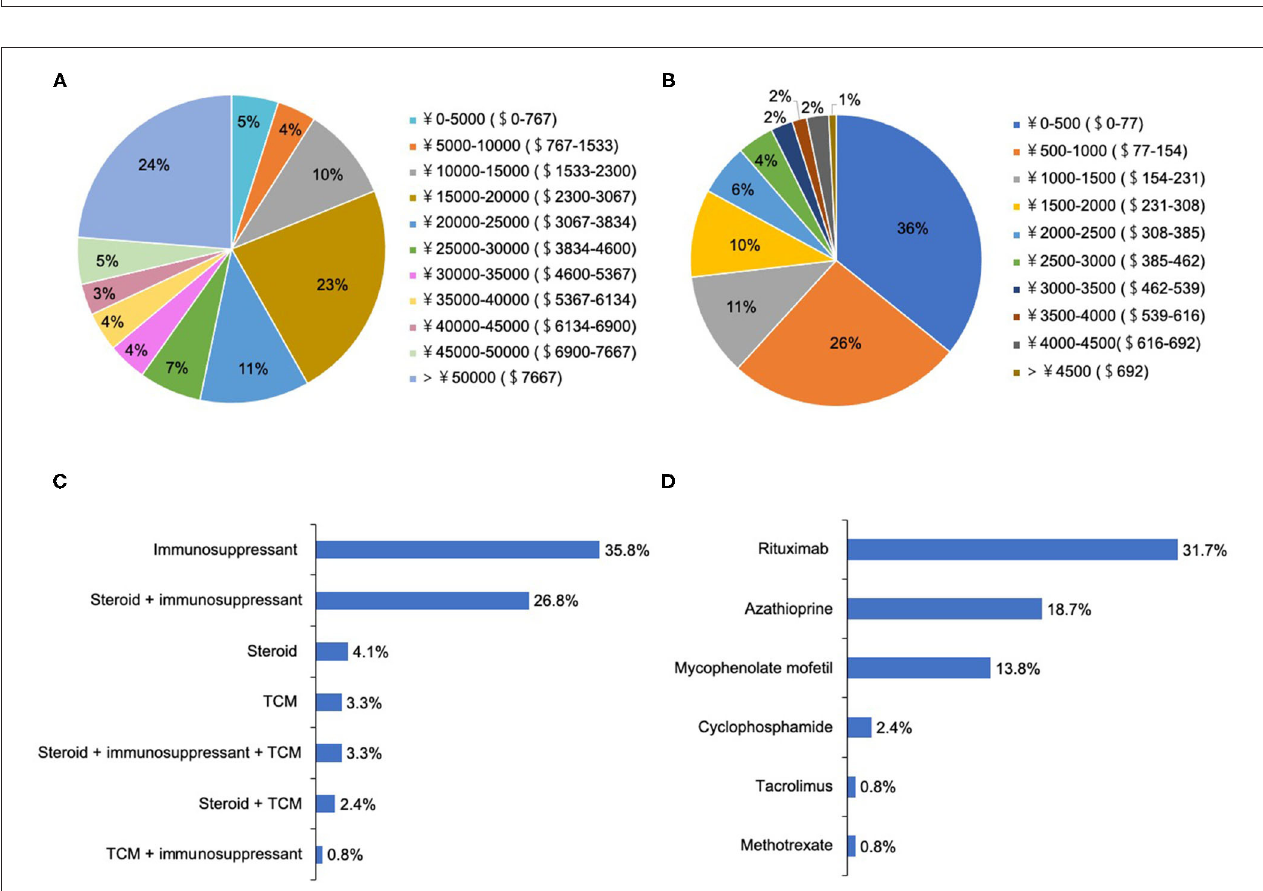
FIGURE 2 | The clinical symptoms at disease onset and throughout the disease course of patients with NMOSD. (A) The clinical symptoms at disease onset. (B) The clinical symptoms throughout the disease course. Cognition indicated attention, concentration, recognition, judgment, and memory.